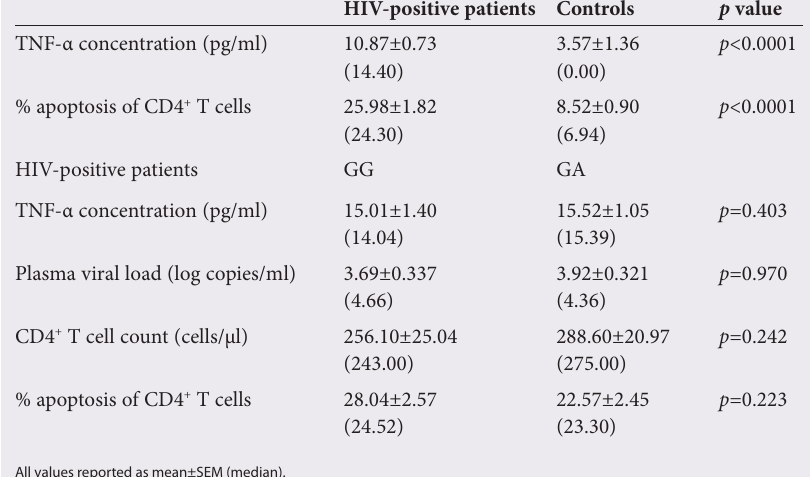
Table 2. Mean TNF-α concentration and markers of HIV-1 progression in the HIV-positive and control cohorts. Markers of HIV-1 progression within the -308 GG and -308 GA genotypes of the HIV-positive cohort HIV-positive patients